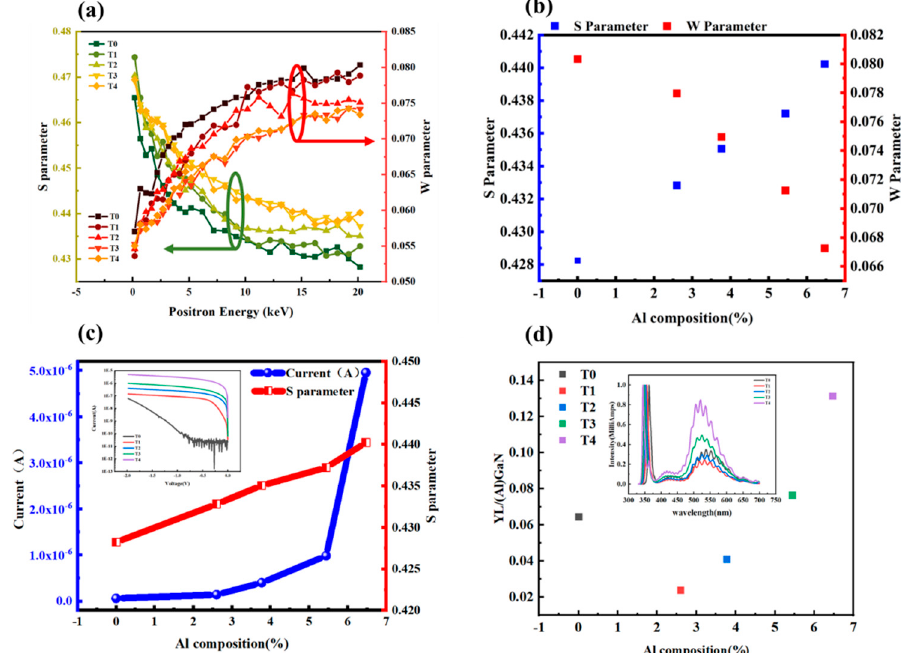
Figure 4. ( a ) The dependence of low momentum parameter S and high momentum parameter Won positron incident energy in the five samples. ( b ) The Al composition dependences of S parameter and W parameter. ( c ) Reverse current at the -2V bias (blue) and S parameter (red) versus Al composition in AlGaN; the inset is reverse I–V curves of samples T0–T4. ( d ) Al composition dependence of S parameter and W parameter; the inset is PL spectra of five samples T0–T4.